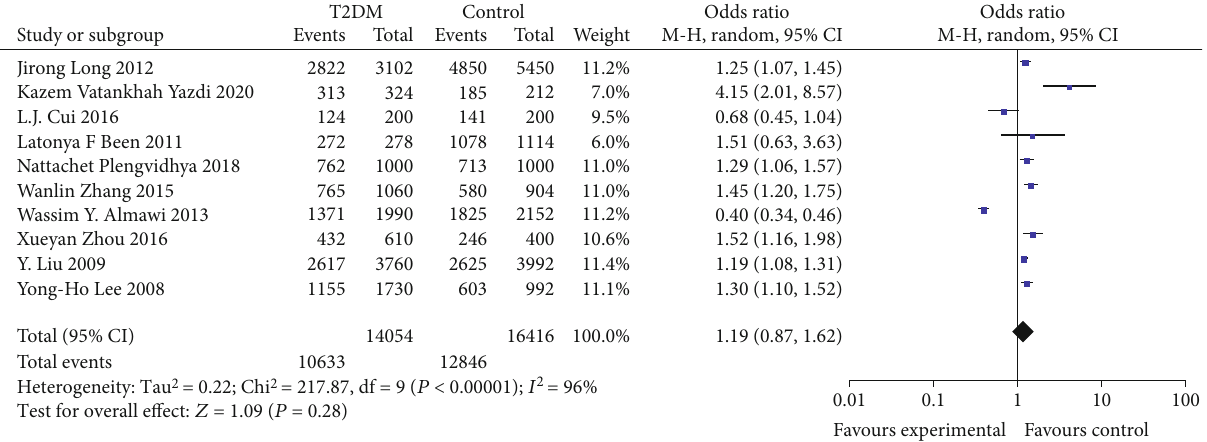
Figure 2: Forest plot of meta-analysis of the association between KCNQ12237892 locus and T2DM under the allele model.